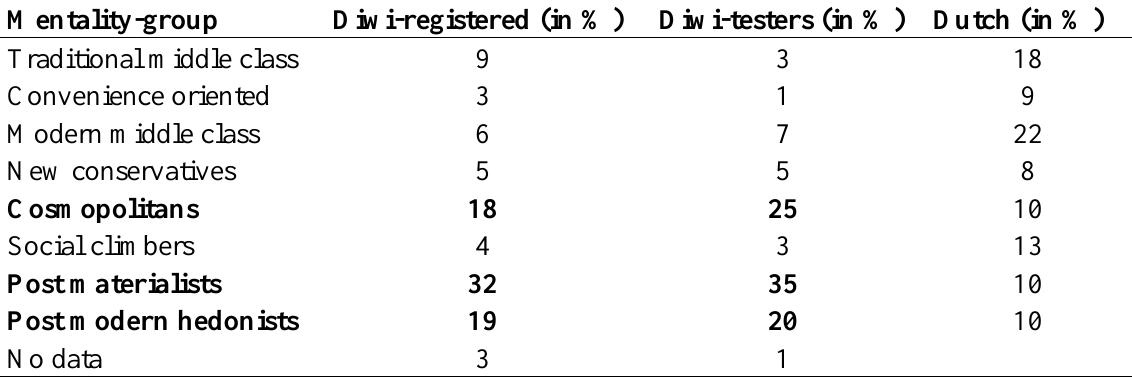
Table 1. Distribution of mentality classes: comparison between all registered Diwi applicants (Diw-registered) and the Diwi- testers, and Dutch citizens.